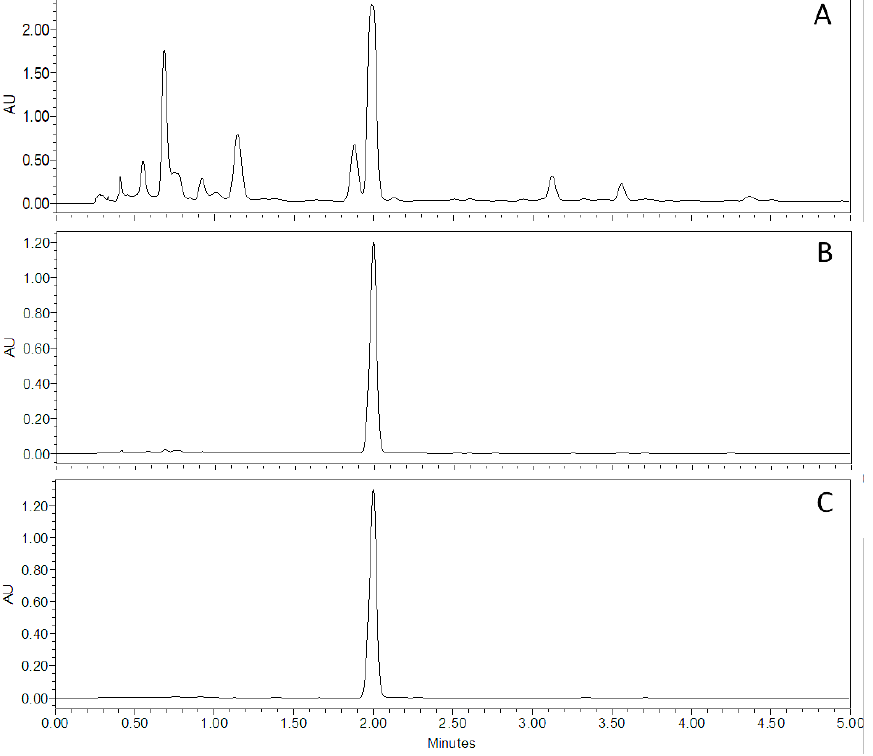
Figure 2. Chromatographic profile of the S. amarissima aerial parts in the ( A ) EtOAc extract, ( B ) amarisolide A isolated as a concentrated metabolite in the EtOAc extract, and ( C ) amarisolide A standard with a retention time of 1.99 min. All chromatograms were read at a wavelength of 256 nm.